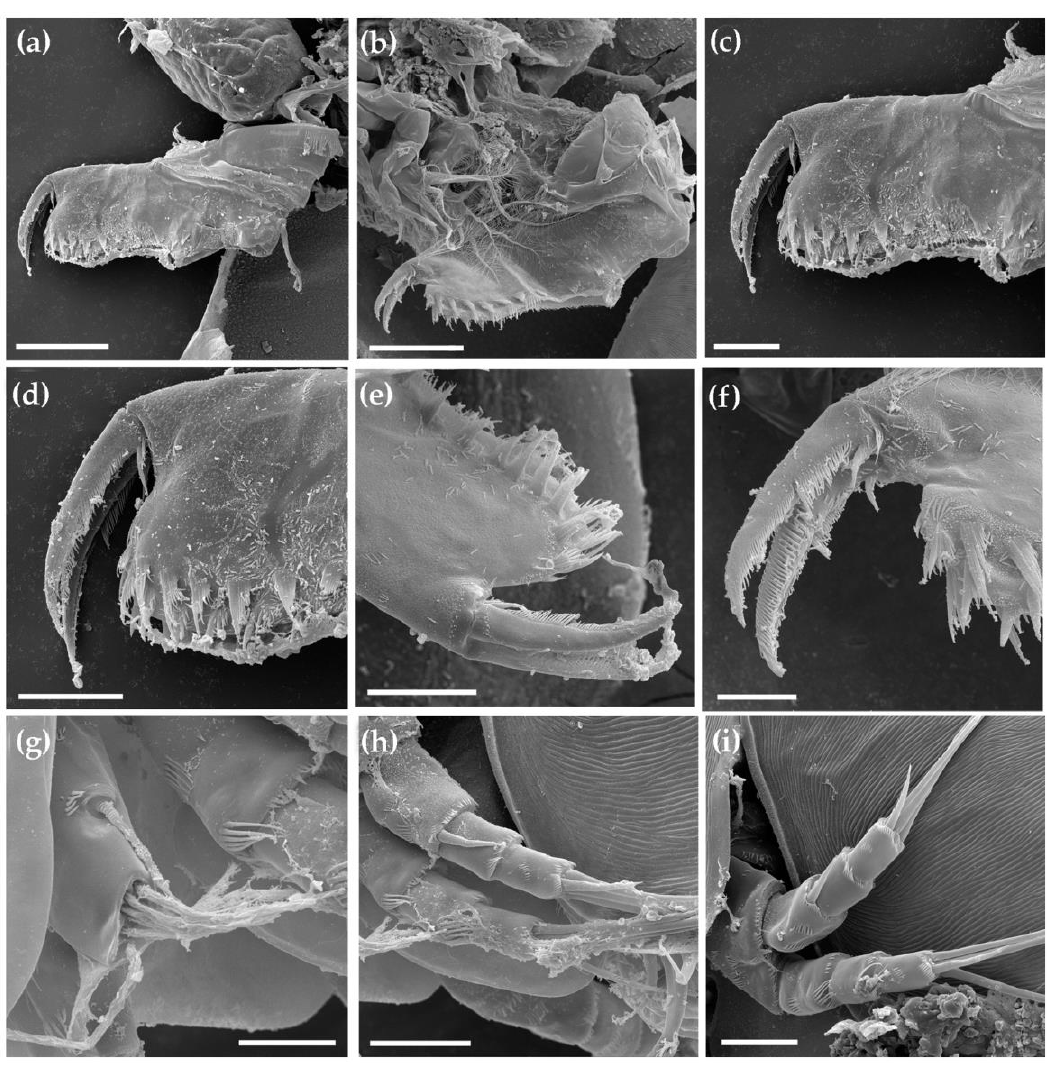
Figure 14. Anthalona mediterranea , an adult parthenogenetic female from Wadi Maidaq — Blue Pool, United Arab Emirates. ( a – c ) Postabdomen, lateral view; ( d – f ) postabdominal claws; ( g ) antenna I; ( h , i ) antenna II. Scale bars: 0.05 mm for ( a , b ), 0.02 mm for ( c – e , h , i ), 0.01 mm for ( f , g ).